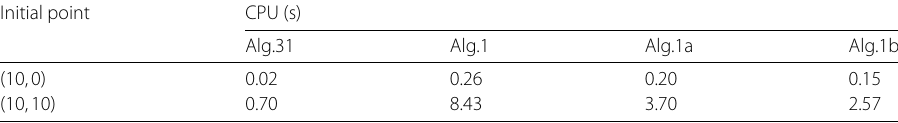
Table 4 The CPU time from Alg.31, Alg.1, Alg.1a and Alg.1b respectively Initial